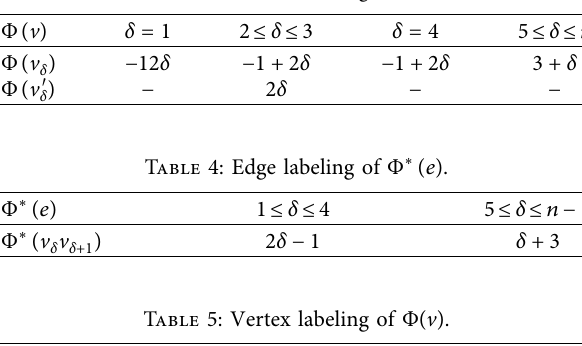
Table 3: Vertex labeling of Φ ( v ).